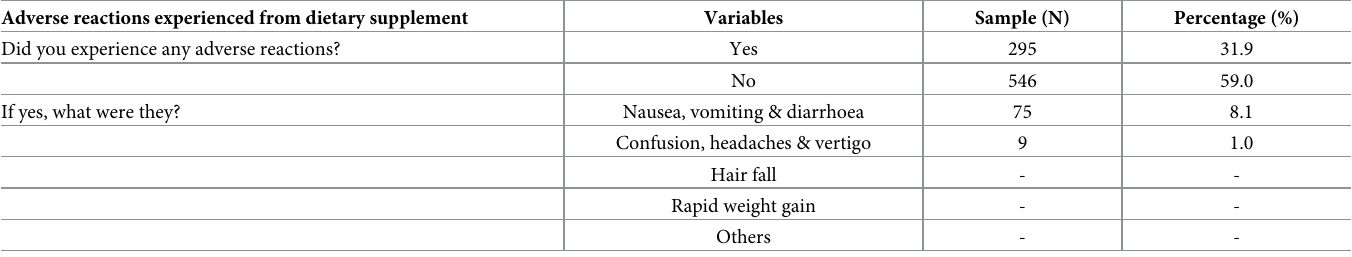
Table 6. Adverse reactions experienced from dietary supplement. Adverse reactions experienced from dietary